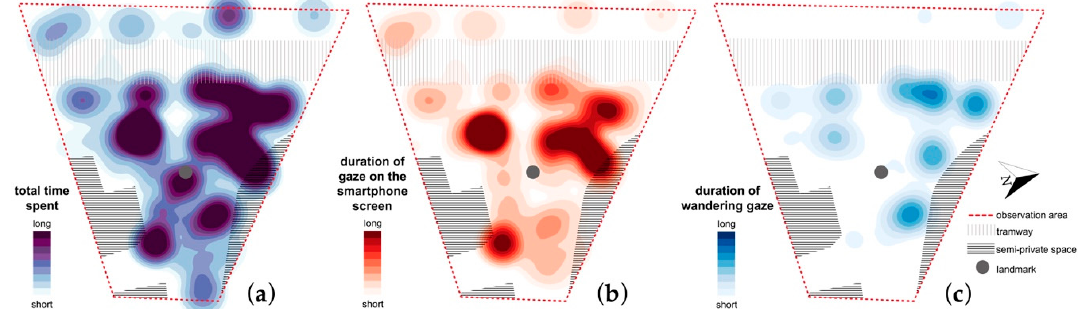
Figure 11. Heatmaps of stationary activities of smartphone users that show ( a ) total time spent, ( b ) duration of gaze on the smartphone screen, and ( c ) duration of wandering gaze. Maps were generated with the QGIS built-in heatmap renderer by using the quartic kernel shape function.